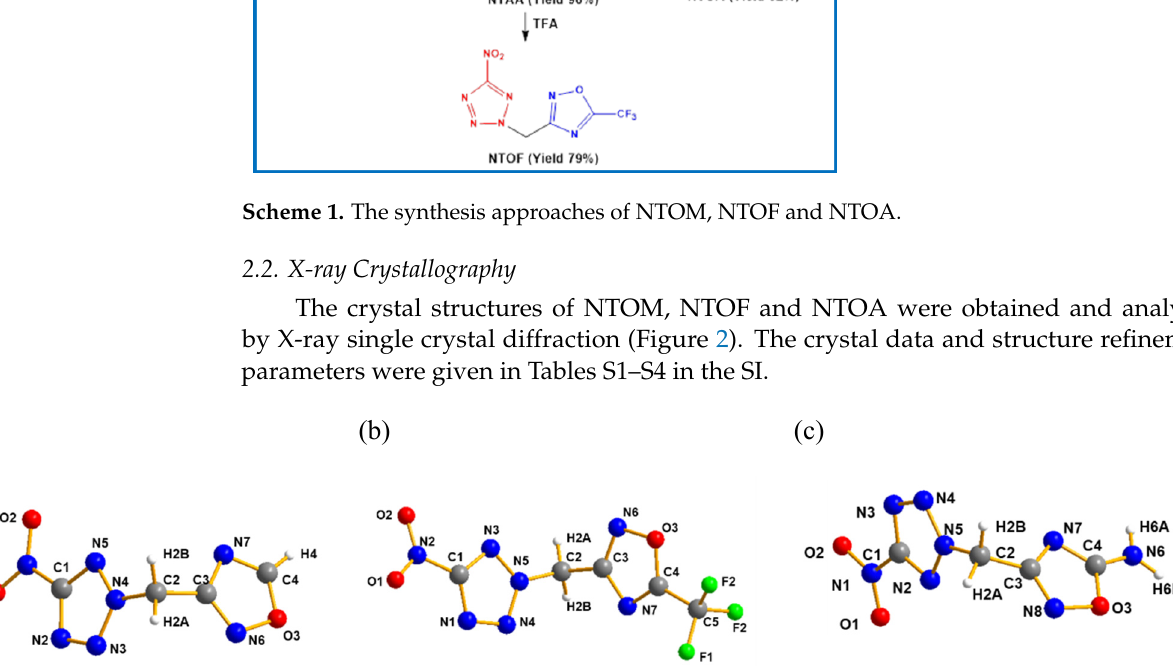
Figure 2. Single-crystal X-ray structures of NTOM ( a ), NTOF ( b ) and NTOA ( c